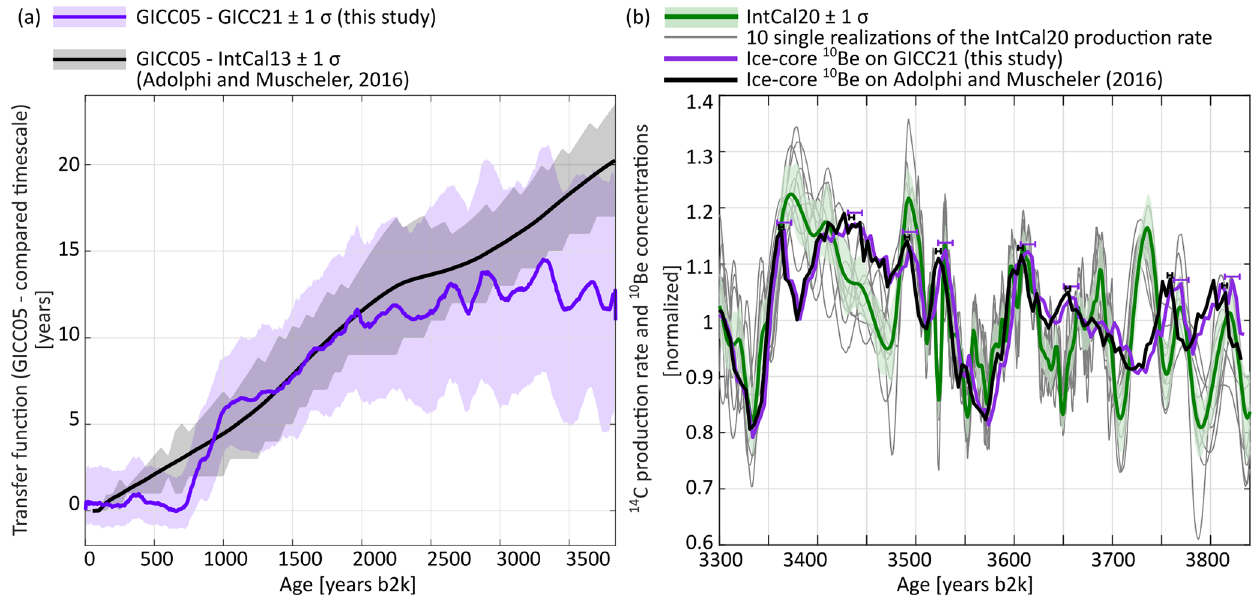
Figure 7. (a) Comparison of the transfer function GICC21–GICC05 with the transfer function modeled by Adolphi and Muscheler (2016), based on 10 Be data from the GRIP ice core and converted to (cid:49) 14 C by modeling and compared to the (cid:49) 14 C variations in IntCal13. The agreement between GICC21 and IntCal is supported by the closeness of the two transfer curves. We observe two notable differences between the transfer curves: between 500 and 1000b2k, where the effect of the 1000-year smoothing of the Adolphi and Muscheler approach is evident (used in the 10 Be– 14 C comparison to avoid matching spurious peaks), and possibly between 3400 and 3835b2k, where some offset (7 ± 6 years) towards older GICC21 ages is still observed. (b) 10 Be concentrations measured in the GRIP ice core (Muscheler et al., 2009) are shown in purple for GICC21 and black for the Adolphi and Muscheler timescales, with horizontal bars highlighting the uncertainties in the peak positioning. The data were smoothed with a 20-year running average and detrended to remove the long-term trend. The 14 C production rate (green), based on the tree-ring timescale, is obtained from carbon-cycle modeling of the 14 C data of IntCal20 (methods outlined in Muscheler et al., 2005). Single realizations of the IntCal20-based production curve show that the position of the peaks underlying IntCal20 can vary slightly, so that the average curve should be handled with care when performing timescale studies (Muscheler et al., 2020). The alignment with IntCal20 is kept within uncertainties throughout the period shown, with possibly GICC21 better aligned in the last century. Any production rate differences between tree-ring data and ice cores that cannot be resolved within realistic dating offsets (e.g., the period 3700–3740b2k) could be explained by underestimated data uncertainties or by transport and deposition effects on 10 Be, since major carbon-cycle changes in this period are unlikely (Muscheler et al.,